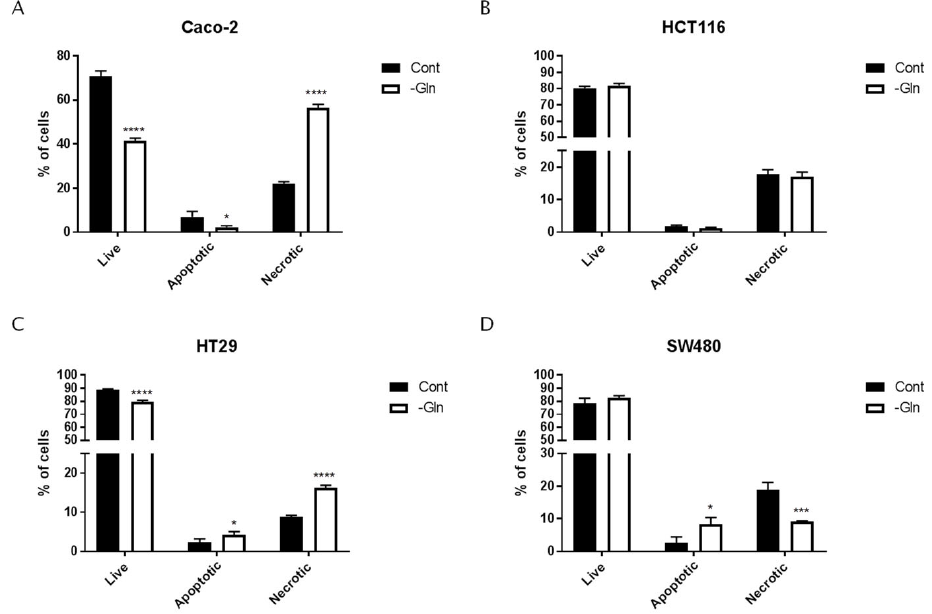
Figure 3. Analysis of cell death in colorectal cancer cells (( A ) Caco-2, ( B ) HCT116, ( C ) HT29, ( D ) SW480). Cell death was evaluated in colorectal cancer cells in the presence (Cont) or absence (-Gln) of glutamine for 48 h using flow cytometry combined with annexin V and propidium iodide staining. Data are presented as cell percentage; the experiment was performed in triplicate and represents mean ± SD ( n = 3, * p < 0.05, *** p < 0.0005, **** p < 0.0001 compared with Cont). Table 3. The influence of glutamine deprivation on colorectal cancer cell death.